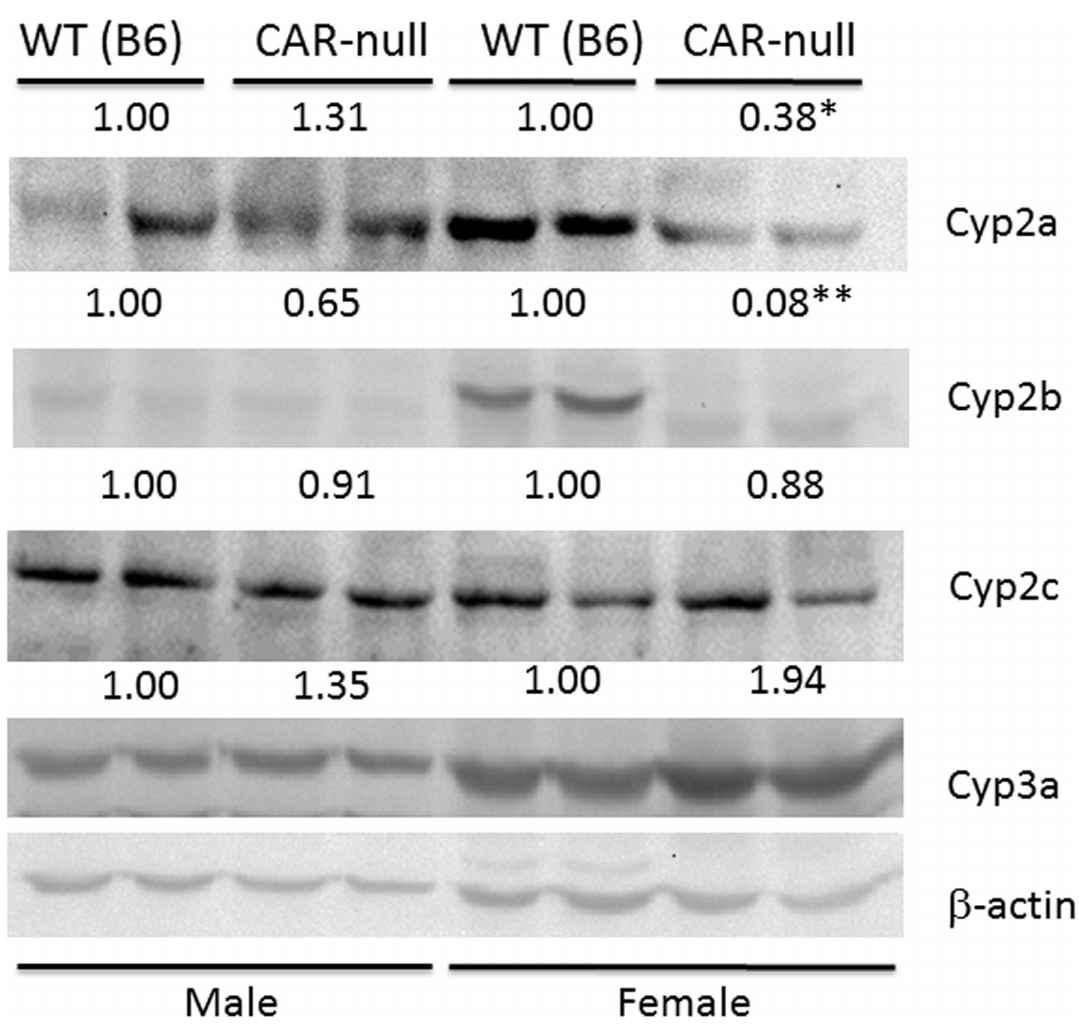
Fig 2. Compensatory changes in CYP protein expression in CAR-null mice. Western blots of male and female CAR-null mice show significantchangesin CYP expression relativeto their WT counterparts. Results are expressedas relativemean of the WT comparedto CAR-nullmice of the same sex. Statistical differences were determined by Student’s t-tests (n = 2) with * (p < 0.05) ** (p < 0.01) indicating